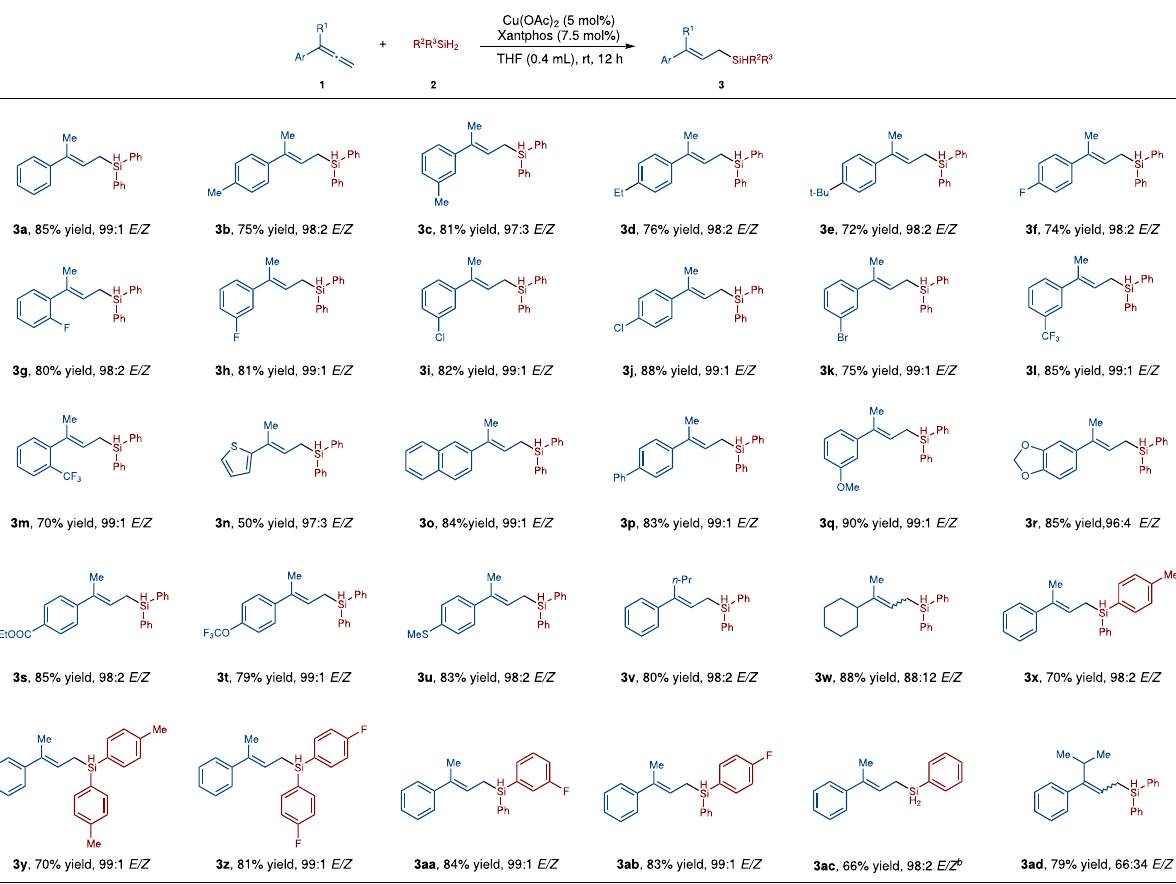
Fig. 2 Scope of 1,1-disubstituted allenes. Otherwise noted, the reaction was performed under the following conditions: a allene (0.20 mmol), R 2 R 3 SiH 2 (0.24 mmol), Cu(OAc) 2 (0.01 mmol, 5 mol%), Xantphos (0.015 mmol, 7.5 mol%), THF (0.4 mL), rt, 12 h; the yield refers to isolated yield; E / Z ratio was determined with GC-MS analysis or HNMR of unpuri fi ed reaction mixture b . Allene (0.20 mmol), PhSiH 3 (0.4 mmol), Cu(OAc) 2 (0.01mmol, 5 mol%), Xantphos (0.015 mmol, 7.5 mol%), THF (0.4 mL), 30 o C, 3